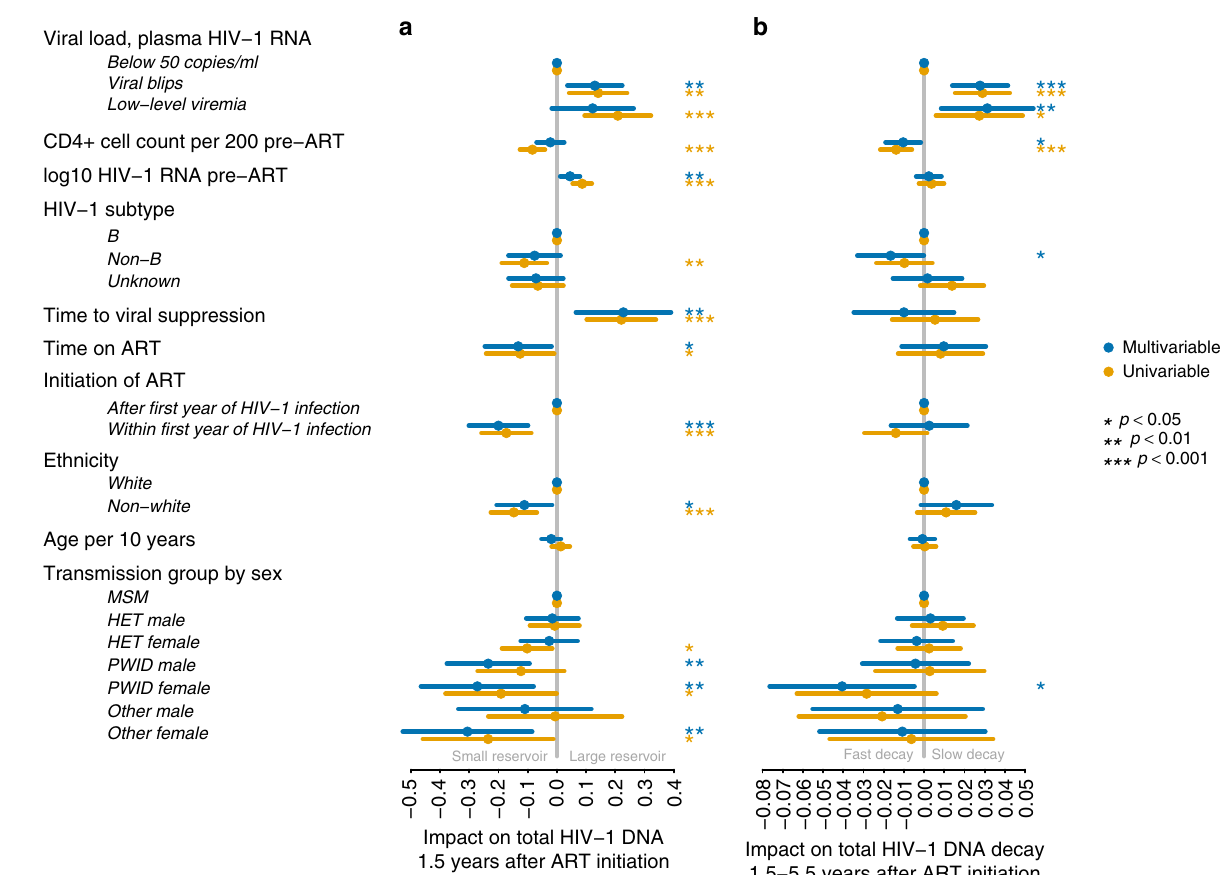
Fig. 3 Determinants of HIV-1 reservoir size and long-term dynamics. a Coef fi cient plot showing covariables associated with total HIV-1 DNA levels 1.5 years after initiation of ART and 95% con fi dence intervals. Viral load <50 HIV-1 RNA copies/ml plasma or low-level viremia refer to the time from 180 days after initiation of ART to the fi rst HIV-1 DNA quanti fi cation. Reference was de fi ned as viral load, plasma HIV-1 RNA below 50 copies/ml, initiation after fi rst year of HIV-1 infection, transmission group MSM, white ethnicity and HIV-1 subtype B. b Coef fi cient plot showing covariables associated with the decay of total HIV-1 DNA levels and 95% con fi dence intervals. Corrected for initial HIV-1 DNA levels using a spline. Viral load <50 HIV-1 RNA copies/ml plasma or low- level viremia or viral blips refer to the time between the fi rst and third sample, i.e., 1.5 – 5.4 years after initiation of ART. Baseline as in panel ( a ). ART antiretroviral therapy, MSM men who have sex with men, HET heterosexual, PWID people who inject drugs, transmission group other includes unknown, and transfusion; time to viral suppression refers to time taken for viral load to drop below 50 HIV-1 RNA copies/ml plasma; CD4 + cell count was